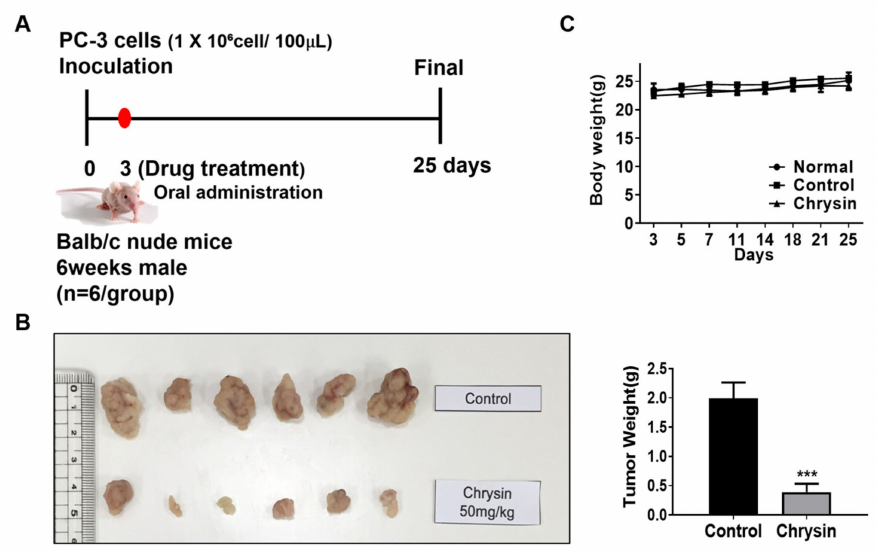
Figure 5. PC-3 xenograft growth-suppressing activity of chrysin in athymic nude mice. ( A ) Diagram of animal study plans and time points; PC-3 cells (1 × 10 6 cells/100 µ L) were mixed with